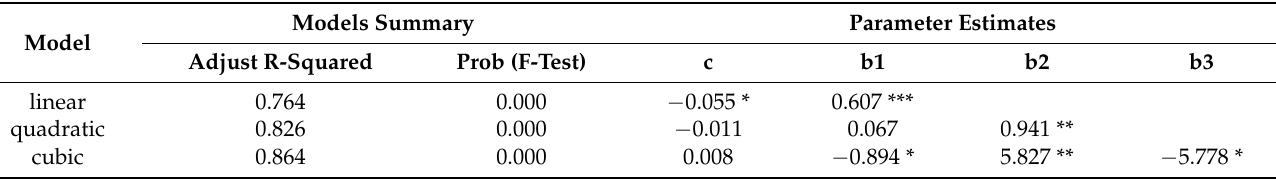
Table 4. Analysis of the different regression fitting